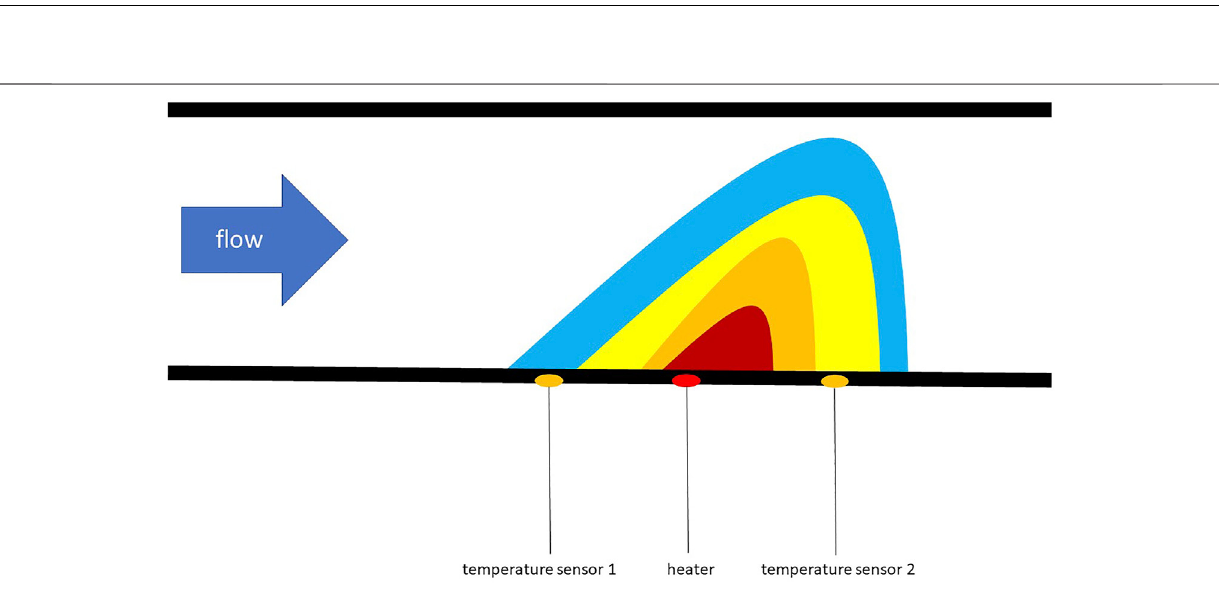
Frontiers in Bioengineering and Biotechnology |